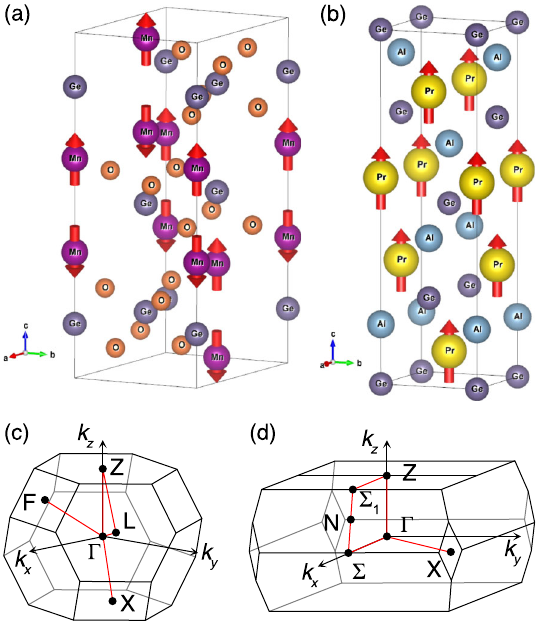
FIG. 10. Fully relativistic band structures of (a) antiferromag- netic MnGeO 3 and (b) ferromagnetic PrGeAl. The Fermi level ( E ) is at 0 F